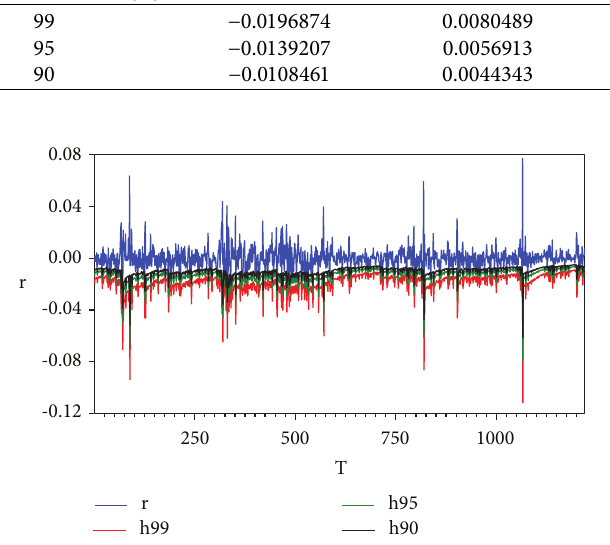
Figure 4: Comparison of VAR-GJR-GARCH model risk value and return rate at different confidence